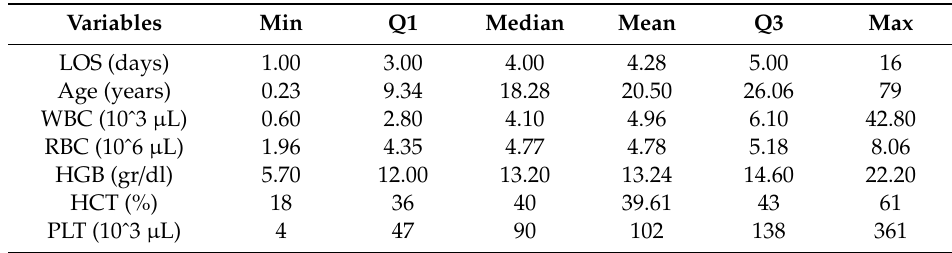
Table 2. Descriptive analysis of continuous demographic and clinical data details for dengue patients in Wahidin hospital.